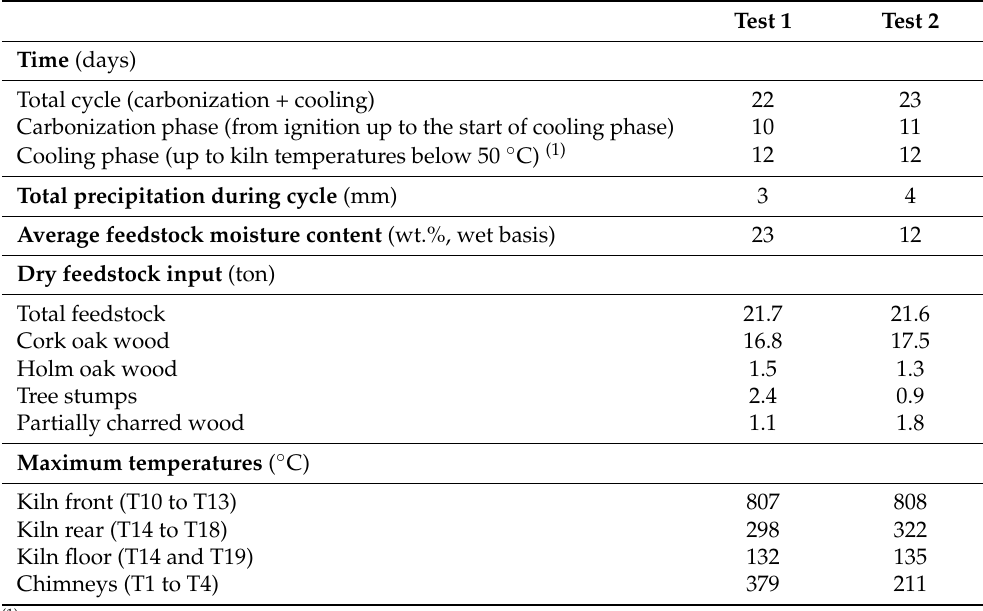
Table 2. Summary of process conditions during the wood carbonization